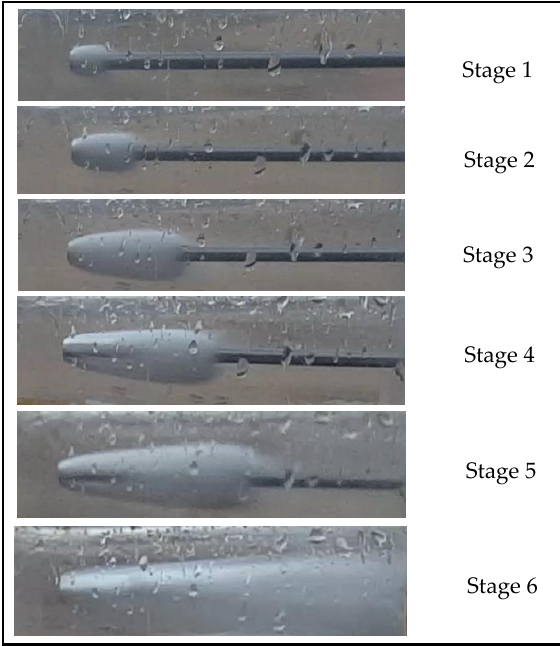
Figure 5. Stages of the bubble development for a flat cavitator.